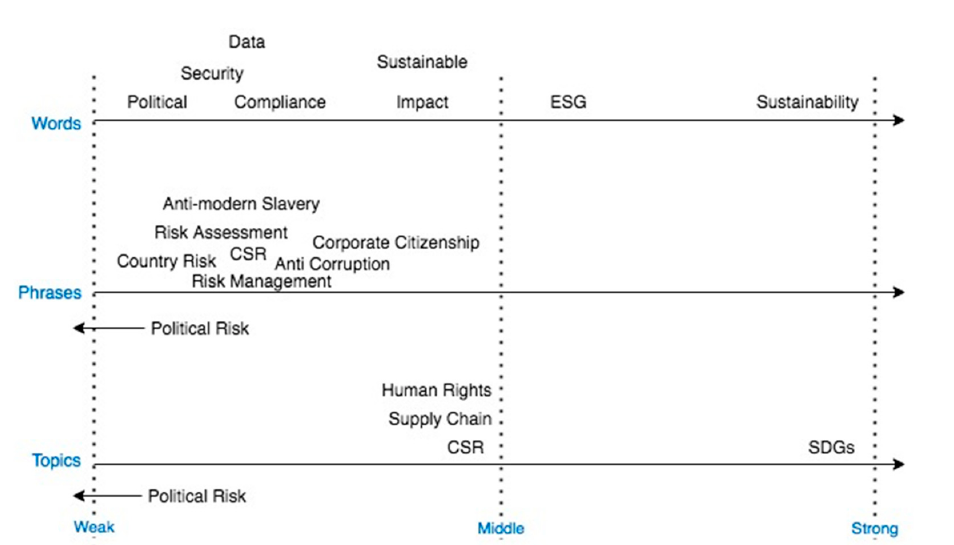
Figure 2. Outcome for re-embedding words, phrases, and topics in relation to sustainability. Placement in the diagram is relative to the frequency of the words/phrases/topics and their connection to sustainability. Source: author’s data.